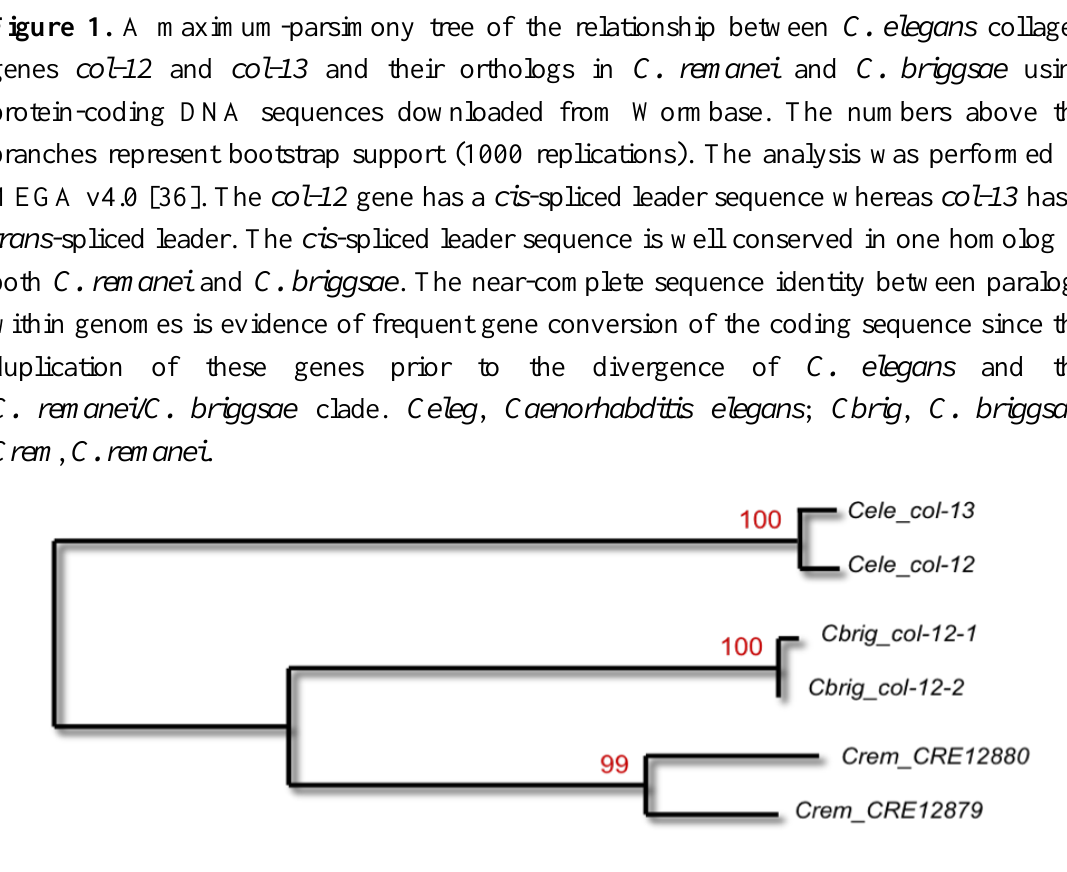
Figure 1. A maximum-parsimony tree of the relationship between C. elegans collagen genes col-12 and col-13 and their orthologs in C. remanei and C. briggsae using protein-coding DNA sequences downloaded from Wormbase. The numbers above the branches represent bootstrap support (1000 replications). The analysis was performed